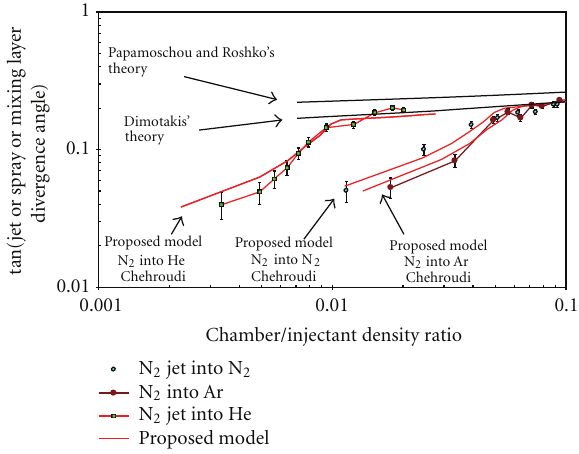
Figure 13: Comparison of the Chehroudi’s proposed growth rate model with experimental data for single jets. Chehroudi et al. [5,